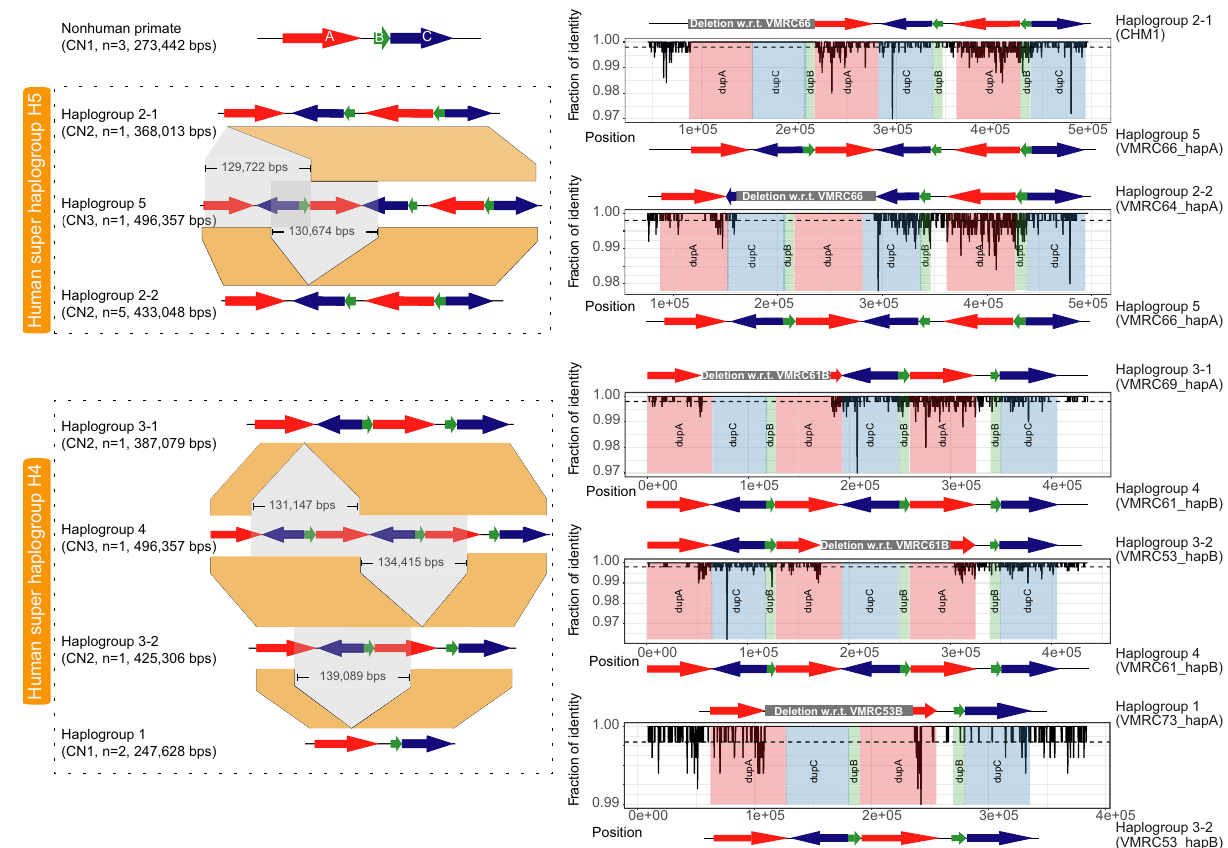
Fig. 2 Complex structural haplotype diversity at the 7q35 TCAF locus in humans. Left panel: Schematic representations of the major- (super haplogroups H4 and H5) and sub-haplogroups identi fi ed from 15 targeted BAC long-read assemblies. Colored arrows are TCAF SDs, and the gray and orange areas indicate putative deletion events and orthologous sequences between haplogroups. For example, despite the similarity in structure, Haplogroup 2-1 and Haplogroup 2-2 likely resulted from different deletion events relative to Haplogroup 5 based on comparative sequence data. Right panel: The comparative sequence analysis between individual haplogroups shows pairwise sequence identities (black lines) over 500 bp windows (sliding by 100 bp). With each plot, colored rectangles correspond to TCAF SDs, while the white region embedded between DupA (red) and DupB (green) blocks represents a 12.3 kbp single-copy unique sequence. Gray rectangles above each sequence identity plot indicate the locations of putative structure variants (Supplementary Data